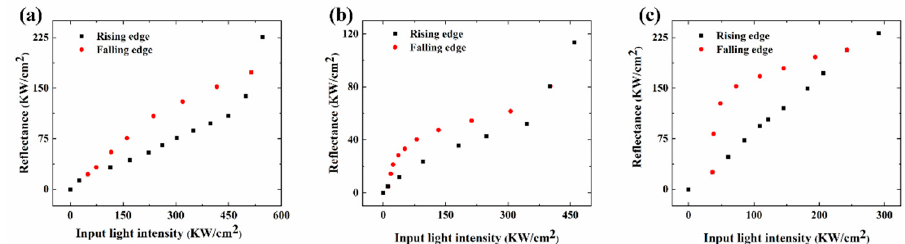
Figure 2. ( a ) Optical bistable hysteresis loop of the device integrated with one layer of GO by COMSOL simulation. ( b ) Optical bistable hysteresis loop of the device integrated with three-layer of GO by COMSOL simulation. ( c ) Optical bistable hysteresis loop of the device integrated with six-layer of GO by COMSOL simulation.